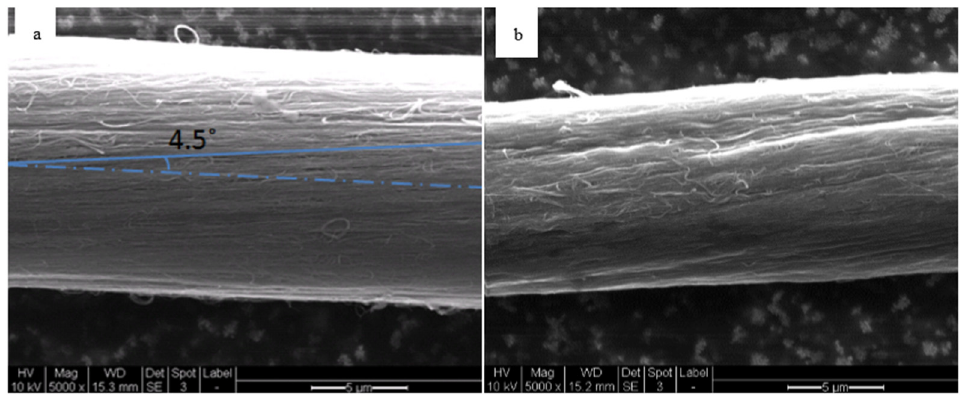
Figure 4. SEM images of ( a ) pristine; and ( b ) EDA/MBDGA cross ‐ linked MWCNT.